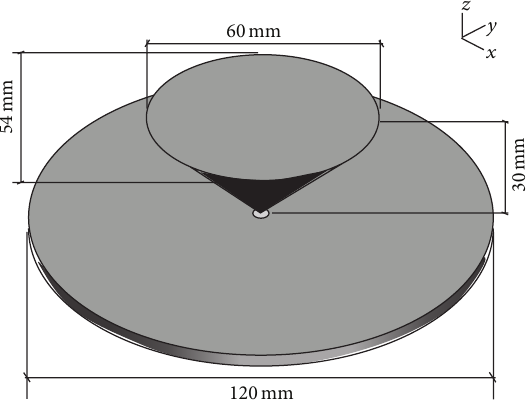
Figure 3: Conical antenna model with elliptical aperture.